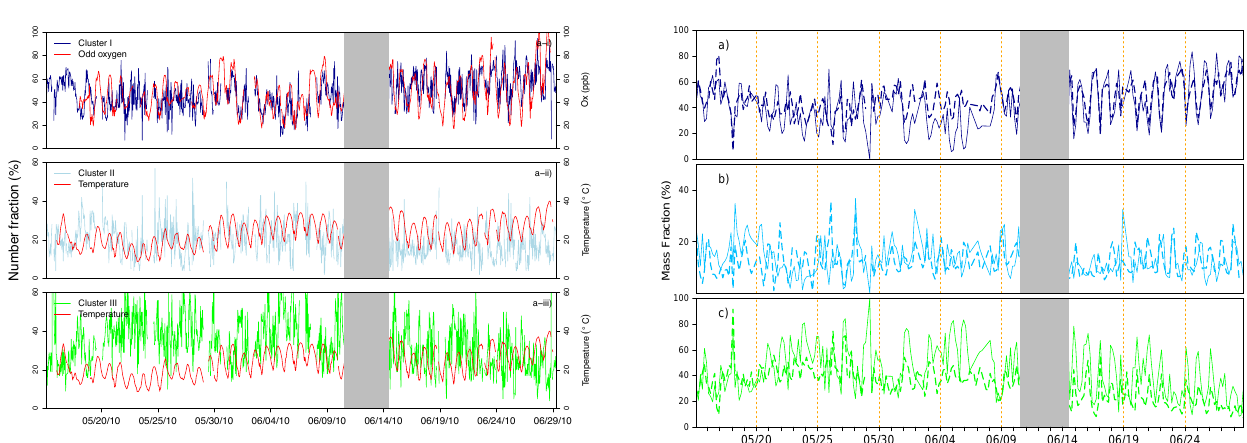
Fig. 8. Solid lines show time series of the mass fraction for (a) clus- ter I (dark blue), (b) cluster II (light blue), and (c) cluster III (green) particles. Dashed lines represent time series of the mass fraction for (a) the sum of high O/C alkane and aromatic SOA (dark blue), (b) the low O/C alkane SOA (light blue), and (c) the sum of COA, PO SOA, and nighttime OA factors (green) identified from ensemble measurements using PMF analysis (Liu et al., 2012). Measurements were averaged to 4-h